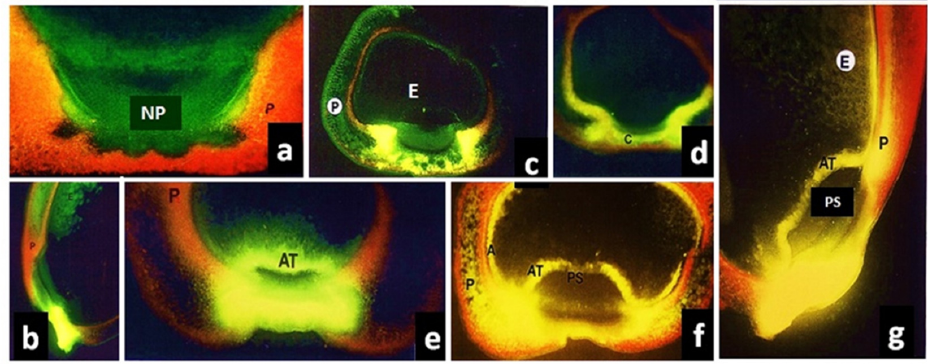
Figure 8. Transport of fluorochromes in caryopsis All are free-hand fresh sections. (a) T.S. of control caryopsis, 5 DAF, showing intense autofluorescence of chlorophyll in pericarp when excited with blue light. Vascular bundles lack chlorophyll. 75x. (b) L.S. of caryopsis, 10 DAF, showing fluorescence of fluorescein after 2 h of transport. Excited with blue light. The dye accumulates in the vascular traces that terminate at the base of the caryopsis. 40x. (c) After 3 h of transport fluorescein has moved through phloem region and part of the pericarp on either side of the placental sac in 10-day-old caryopsis excited with blue light. 40x. (d) T.S. of caryopsis, 5 DAF, showing fluorescence in chalazal complex and adjacent pericarp tissues after transport of fluorescein for 3 h and excited with blue light. 50x. (e) T.S. of caryopsis, 15 DAF, showing intense fluorescence of 5 (6) carboxyfluorescein (CF) in the vascular trace region and aleurone transfer cells after 5 h of movement. Excited with blue light. 50x. (f) T.S. of caryopsis, 30 DAF, showing fluorescence of CF in cells of the aleurone layer and aleurone transfer cells. Excited with blue light after 5 h of dye transport. 50x. (g) L.S. of caryopsis, 30 DAF, showing fluorescence of CF in basal and chalazal complex region, aleurone transfer cells, and aleurone cells after 5h of transport. Excited with blue light. 50x. (A, aleurone cell; AT, aleurone transfer layer; C, chalazal complex; E, endosperm; NP, nucellar projection; P, pericarp; PS, placental